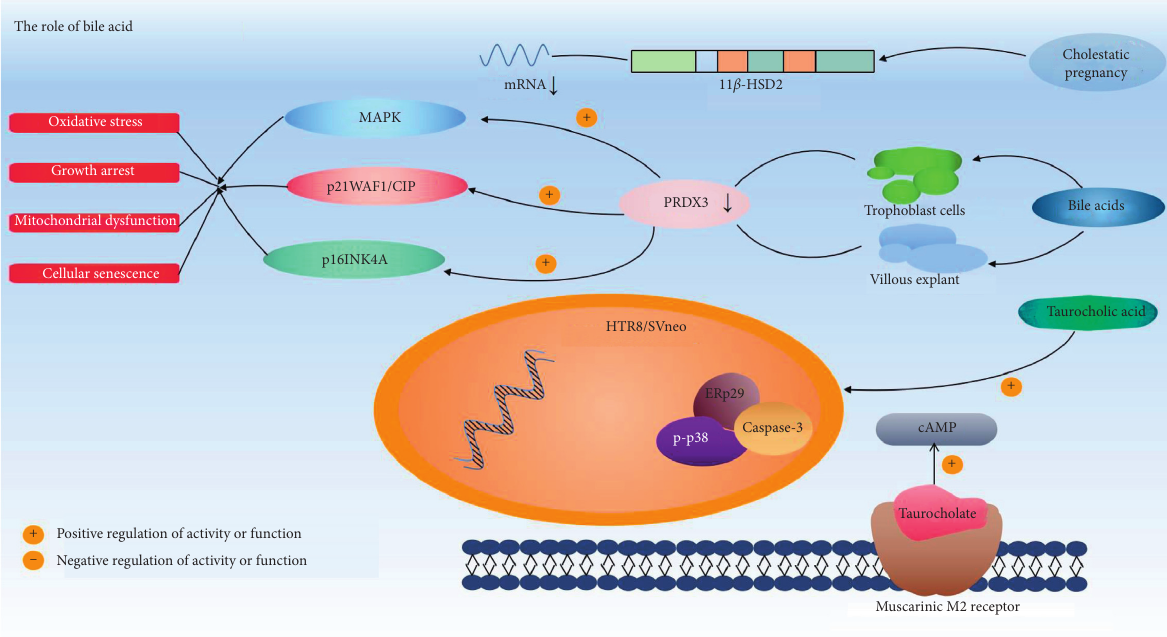
Figure 4: The role of bile acid in the pathogenesis of ICP. Taurocholate can bind to M2 receptors to inhibit cAMP. Taurocholic acid can upregulate ERp29, p-p38, and caspase-3 activities of HTR8/SVneo cells. The level of PRDX3 in trophoblast cells and villous explants treated with bile acids in vitro is downregulated, thereby inducing MAPK, p21WAF1/CIP, and p16INK4A, triggering oxidative stress, mito- chondrial dysfunction, growth arrest, and cell senescence; The expression of 11 β -HSD2 gene was reduced in cholestatic pregnancy. Adjustment events are displayed with arrows. The combination of wavy lines represents the DNA molecules in HTR8/SVneo cells, and a long rectangle shows the 11 β -HSD2 gene